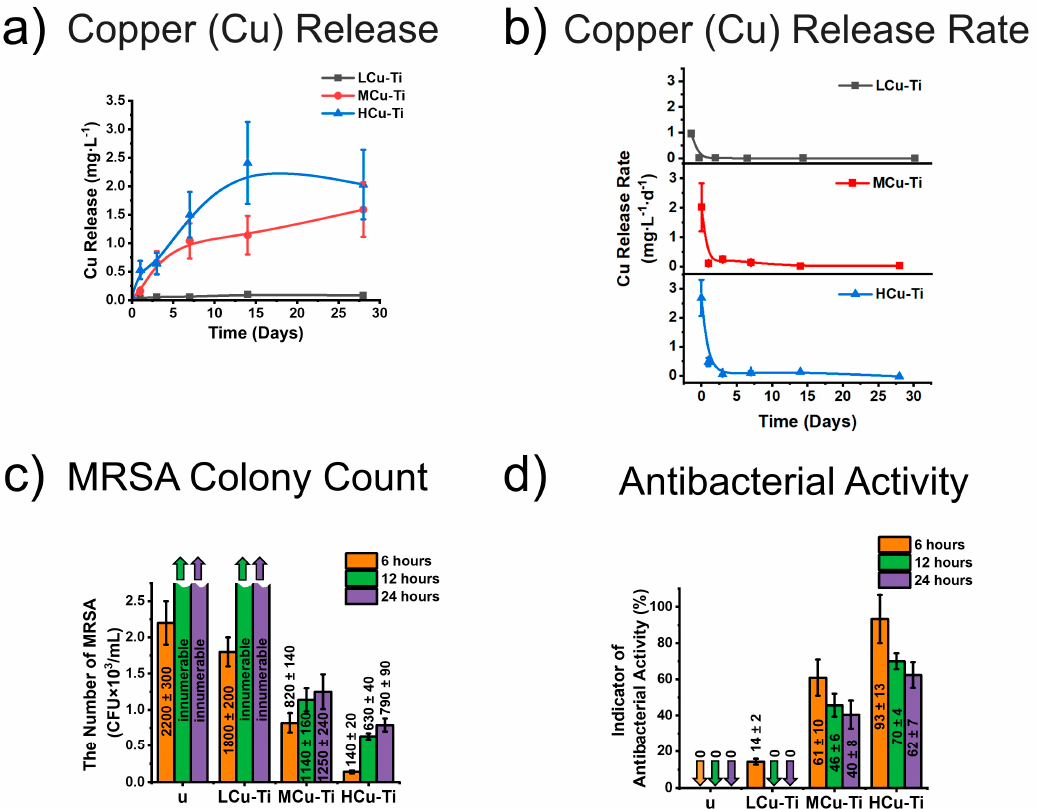
Figure 4. Released amount of copper ions and antibacterial activity of unmodified (u) and surface- modified PLGA scaffold samples (LCu-Ti, MCu-Ti, HCu-Ti): ( a ) released amount of copper ions and ( b ) release rate of copper ions into deionized water from Cu-Ti modified PLGA scaffolds during 28 days, determined via stripping voltammetry, ( c ) number of MRSA colonies (Supplementary Material Figure S9), the word “innumerable” refers to that the Petri dish contained so many MRSA colonies that they could not be counted; ( d ) antibacterial activities calculated on the basis of the number of MRSA colonies